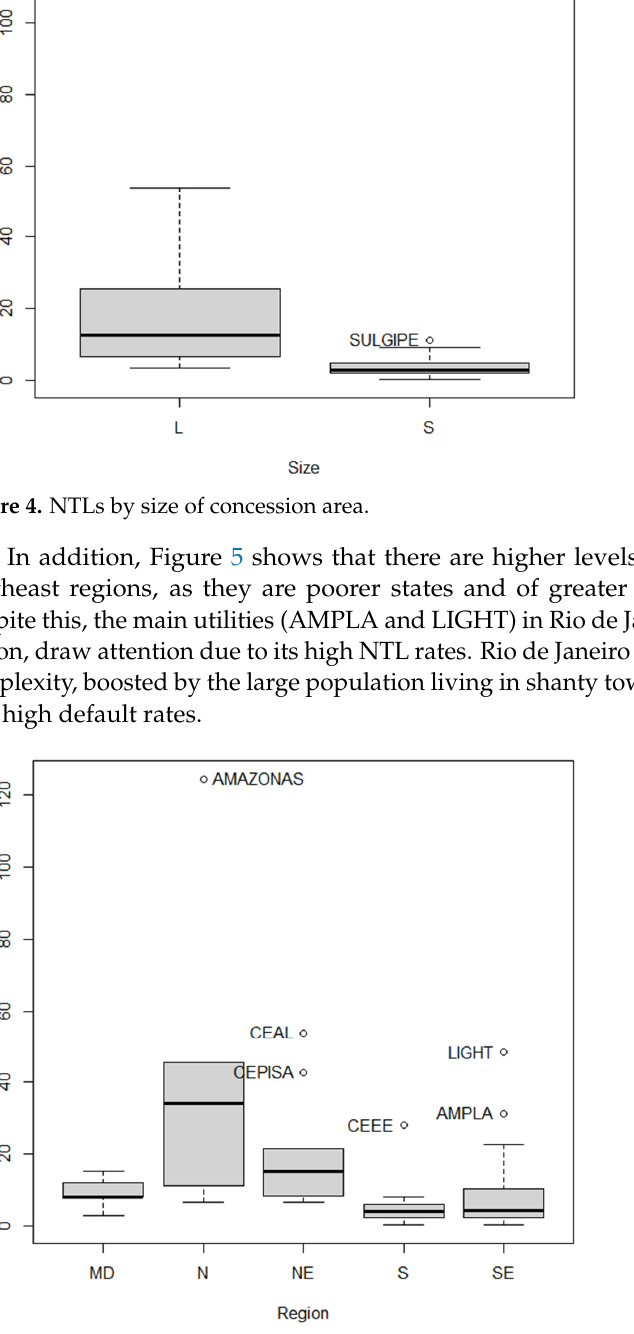
Figure 5. NTLs by region. Figure 5. NTLs by